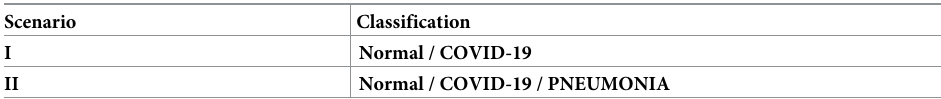
Table 6. Description of classification